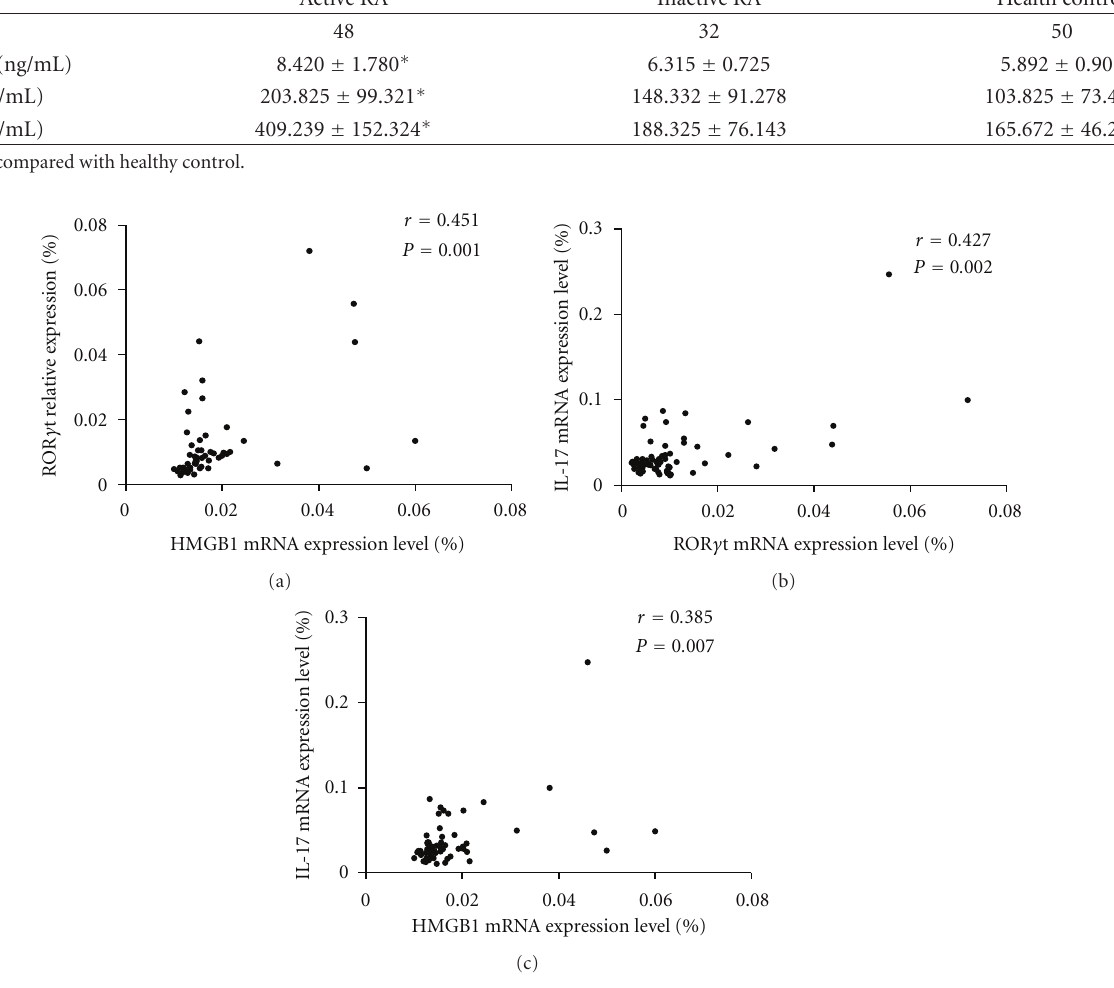
Figure 2: Correlations of IL-17 and ROR γ t and HMGB 1 mRNA level in RA active patients. The mRNA expression levels as determined by RT-qPCR, the values were expressed as the target genes versus β -actin mRNA